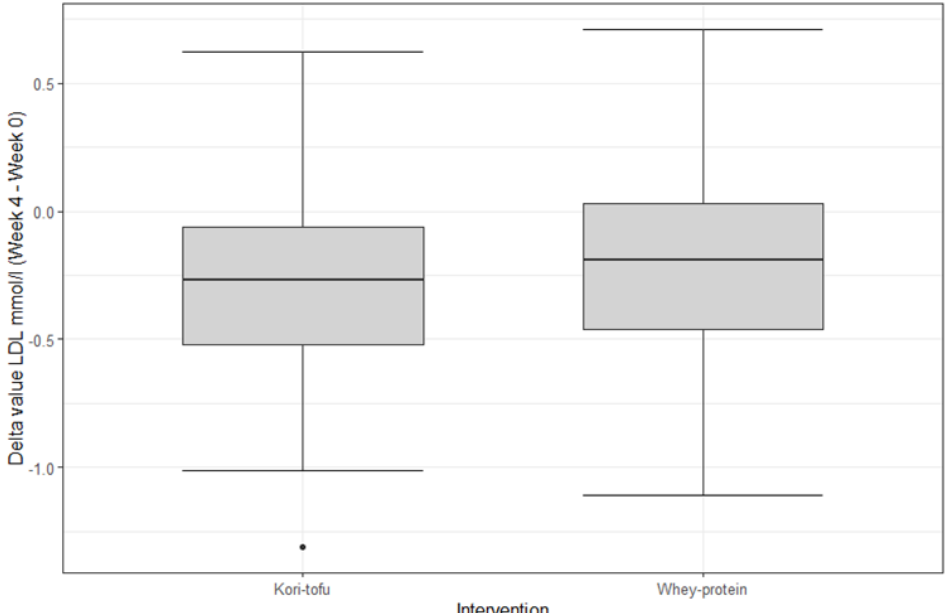
Figure A2. Delta values of LDL cholesterol (mmol/L) per intervention (values week 4–values week 0). Boxplots represent the 25th, 50th (median) and 75th percentile. Antennas represent 1.5 times interquartile range. Dots represent values outside the 1.5 times interquartile range.